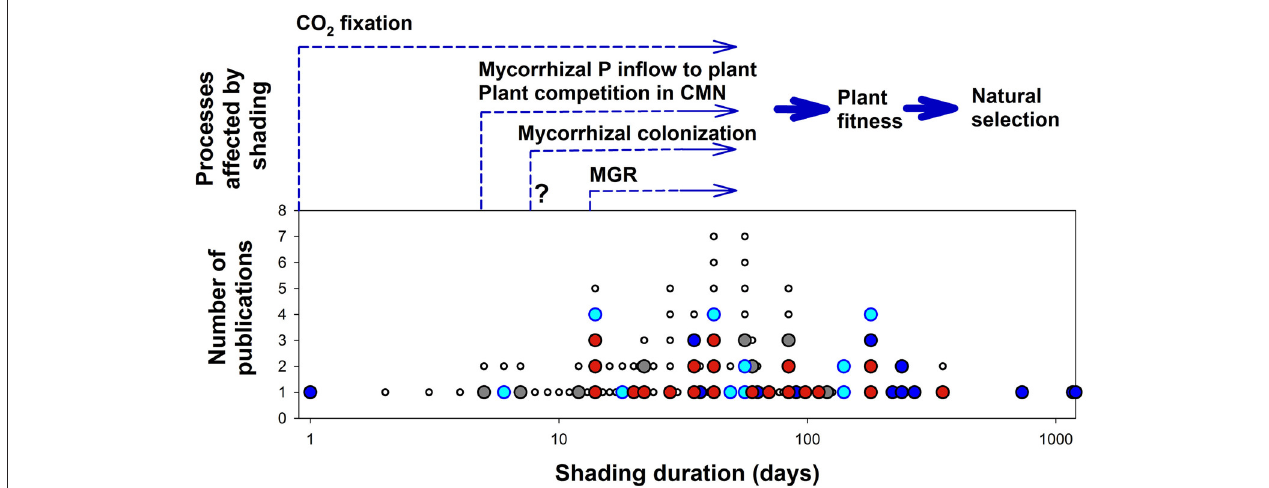
FIGURE 2 | Plant or plant community processes affected by shading at different temporal scales compared to the lengths of shading period applied in the previously published experiments with arbuscular mycorrhizal plants. Cumulative numbers of publications are shown for each shading duration. Each closed circle represents one publication, indicating the shortest shading duration tested. Publications shown in red are those listed in Table 1 , dark blue are publications without non-mycorrhizal control treatment, light blue are publications with no significant impact of either mycorrhiza or light on the plant biomass, and gray indicates publications with confounding factors such as coincidental treatment with shade and temperature shift or those not reporting on plant biomass or those primarily addressing functioning of common mycorrhizal networks (CMN). Each small empty circle indicates repeated observation (sequential harvest) within a publication that is already shown in the figure. Arrows start at the earliest time point when a shading-induced effect in the respective process has been documented. Please note the log scale of the time axis. P, phosphorus; MGR, mycorrhizal growth response (here regarded broadly as a significant difference in biomass production of mycorrhizal vs. non-mycorrhizal plant at a given time point). Uncertainty related to the onset of the statistically significant difference in mycorrhizal colonization levels between shaded and unshaded plants in the publication by Tester et al. (1986) is indicated with a question